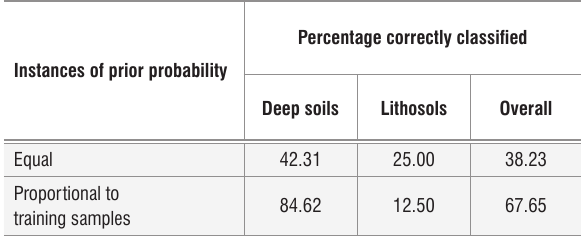
Table 2: Summary of soil association prediction accuracy (%) for Gladstone Instances of prediction for different prior probabilities